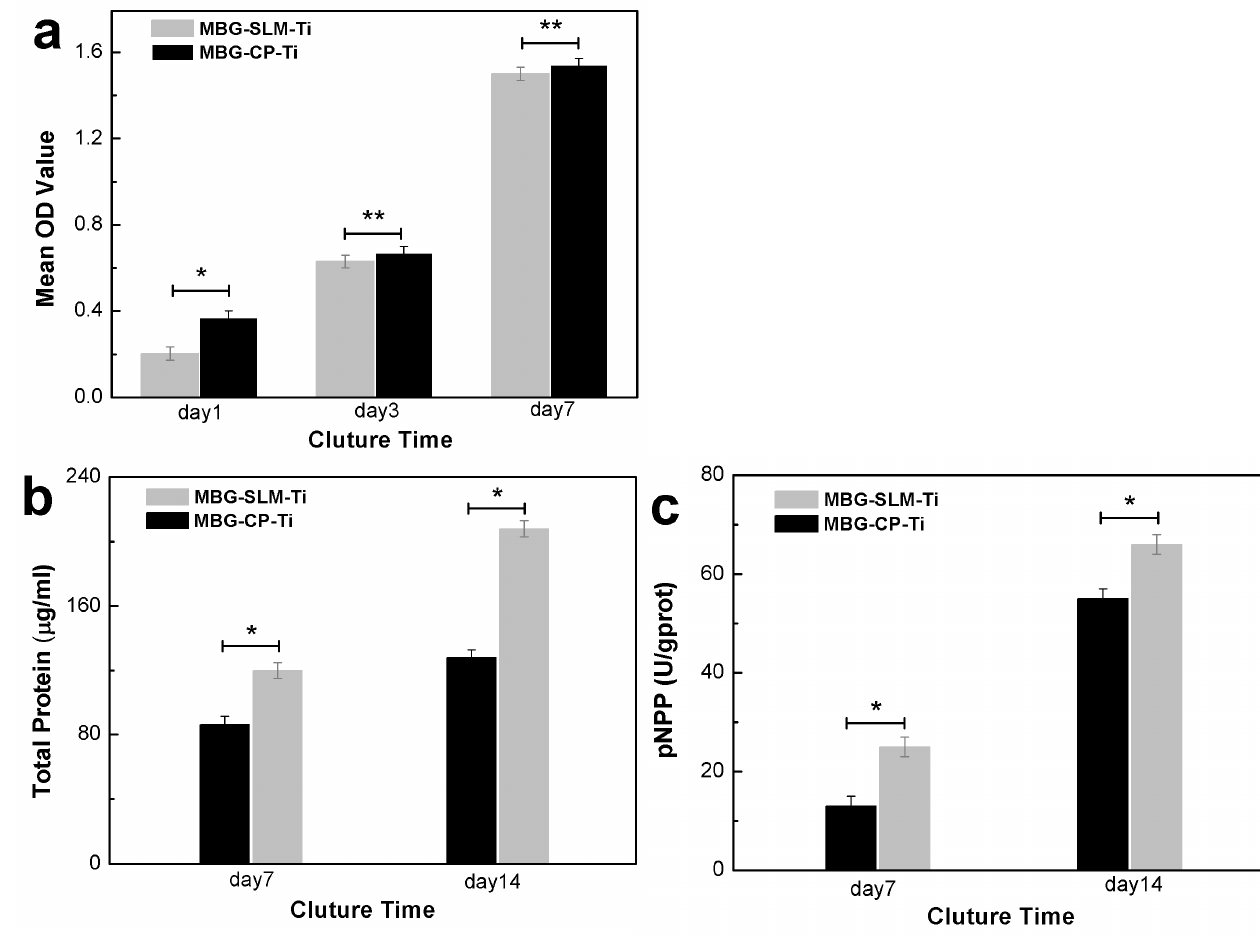
Figure 10. Cell viability evaluated through ( a ) the cell proliferation rates after 1, 3 and 7 days, ( b ) total protein contents and ( c ) ALP activity after 7 and 14 days. (* p < 0.05, ** p <